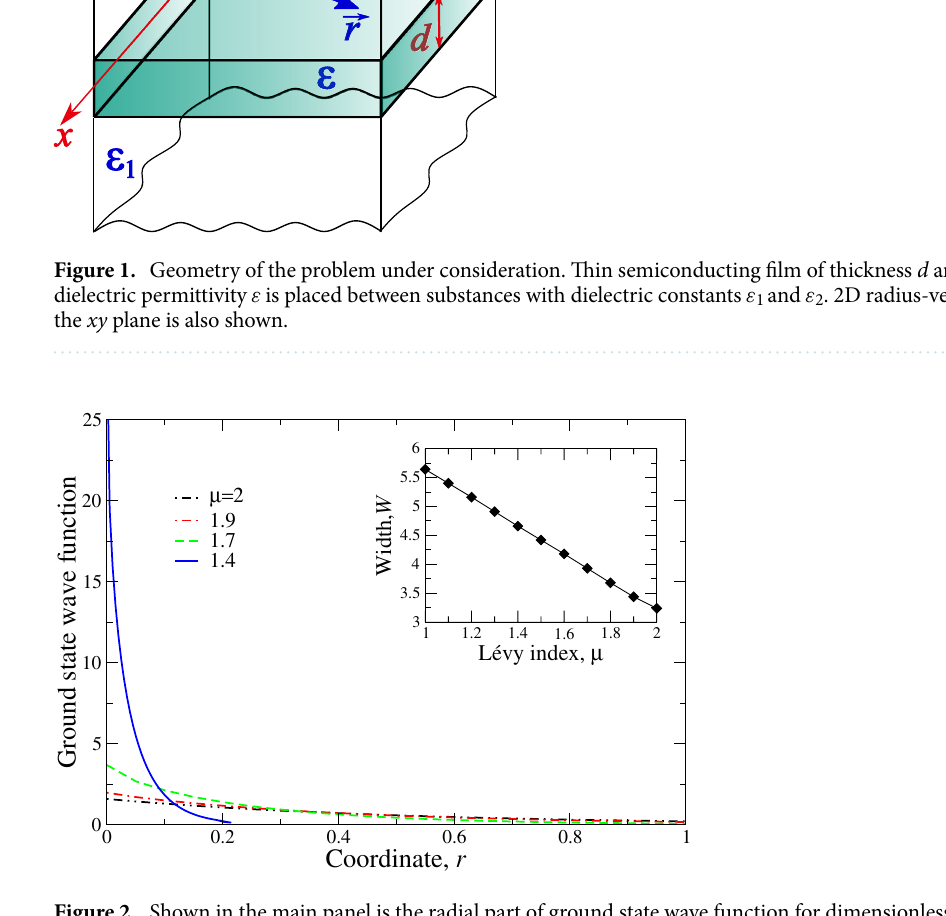
Figure 2. Shown in the main panel is the radial part of ground state wave function for dimensionless screening radius ξ = 0.1 (see Eq. (27)) and different Lévy indices µ , shown in the legend. It is seen that as Lévy index decreases from µ = 2 (corresponding to the case of ordinary Laplacian in the Schrödinger equation) to µ = 1.4 , the ground state wave function becomes progressively more localized. It can be shown (see below) that at µ → 1 the wave function tends to Dirac δ function. The inset reports the breadth of initial Lévy distribution (2) as the function of Lévy index µ . The breadth has been taken at the point, when the corresponding Gaussian (Lévy distribution at µ = 2 ) normalization equals to 0.999. This approximately corresponds to 3 σ in Eq. (2), where σ = 1